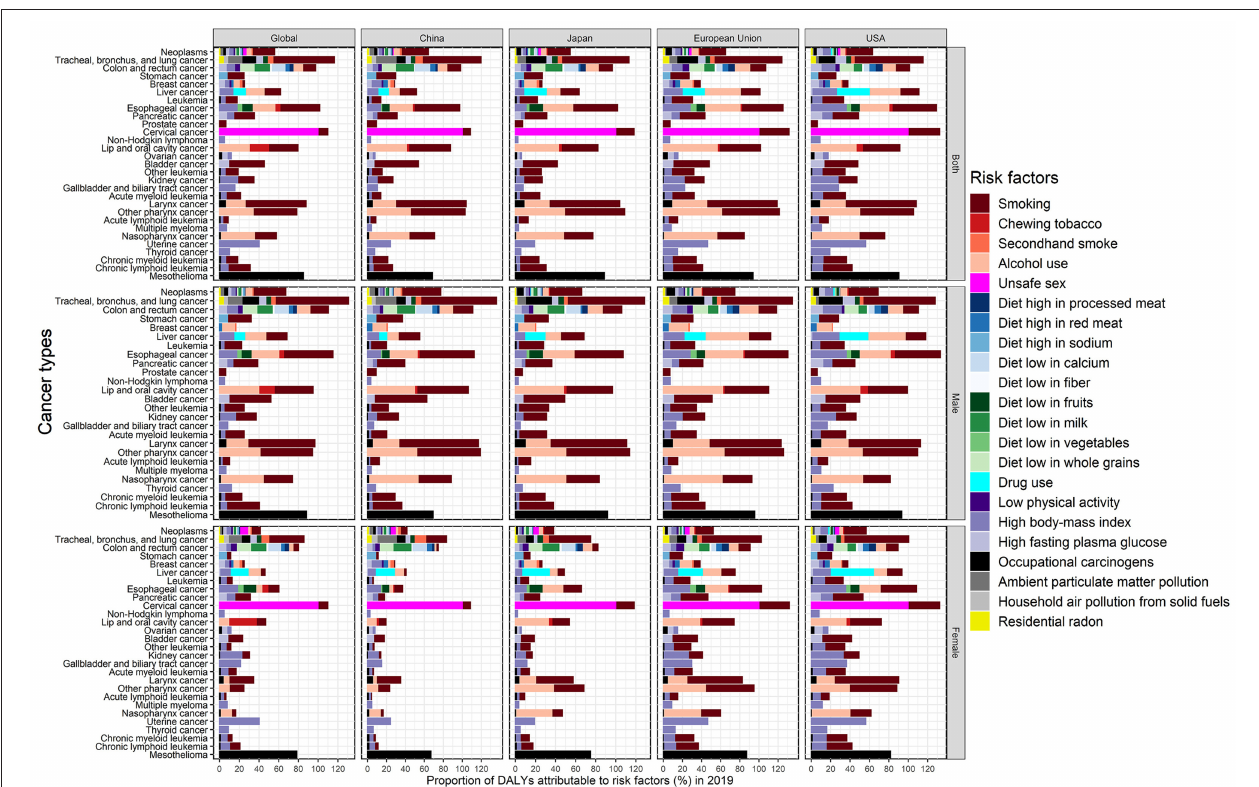
FIGURE 5 | The population attributable fraction of all identified risk factors for 29 neoplasms groups in the world, China, Japan, European Union, and USA stratified by gender in 2019.